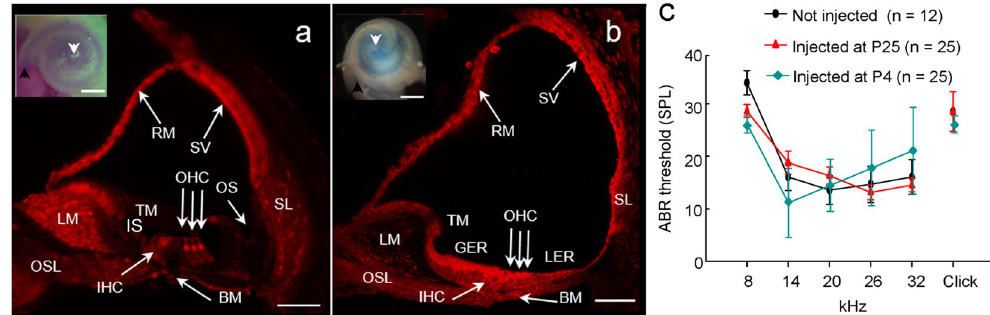
Figure 1. In vivo fluid delivery via canalostomy to mouse cochlea. ( a,b ) Midmodiolar cochlear sections from P25 ( a ) and P4 ( b ) mice injected with fluorescent wheat germ agglutinin (which labels cell membranes) examined by confocal microscopy; scale bars: 50 μ m. Insets: representative light microscopy images of cochleae from P25 ( a ) or P4 ( b ) mice injected with bromophenol blue, dissolved in PBS; images were acquired 5 min after canalostomy; scale bars: 500 μ m; arrowheads point to the base (black) and apex (white) of the cochlea. BM: basilar membrane; GER, greater epithelial ridge; IHC: inner hair cell; IS: inner sulcus; LER, lesser epithelial ridge; LM: spiral limbus; OHC: outer hair cells; OS: outer sulcus; OSL, osseous spiral lamina; RM: Reissner’s membrane; SL: spiral ligament; SV: stria vascularis; TM: tectorial membrane. ( c ) Hearing thresholds determined by analysis of auditory brainstem responses (ABR) in wild type mice injected at P25 (red), P4 (cyan) and non- injected controls (black); ordinates are sound pressure levels (SPL) relative to 20 µ Pa: Error bars represent standard error of the mean